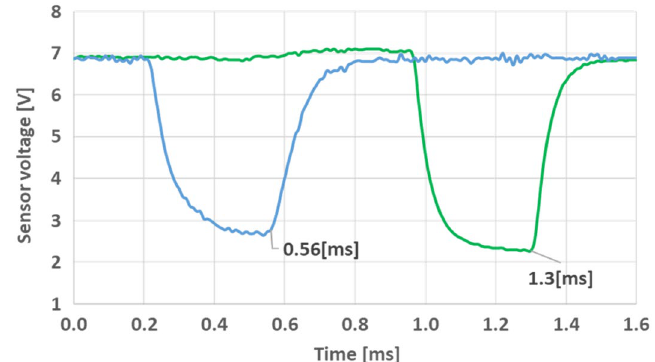
Figure 7. Sensing voltage detection of the first stage velocity, represents velocity of 33.8 m/s.